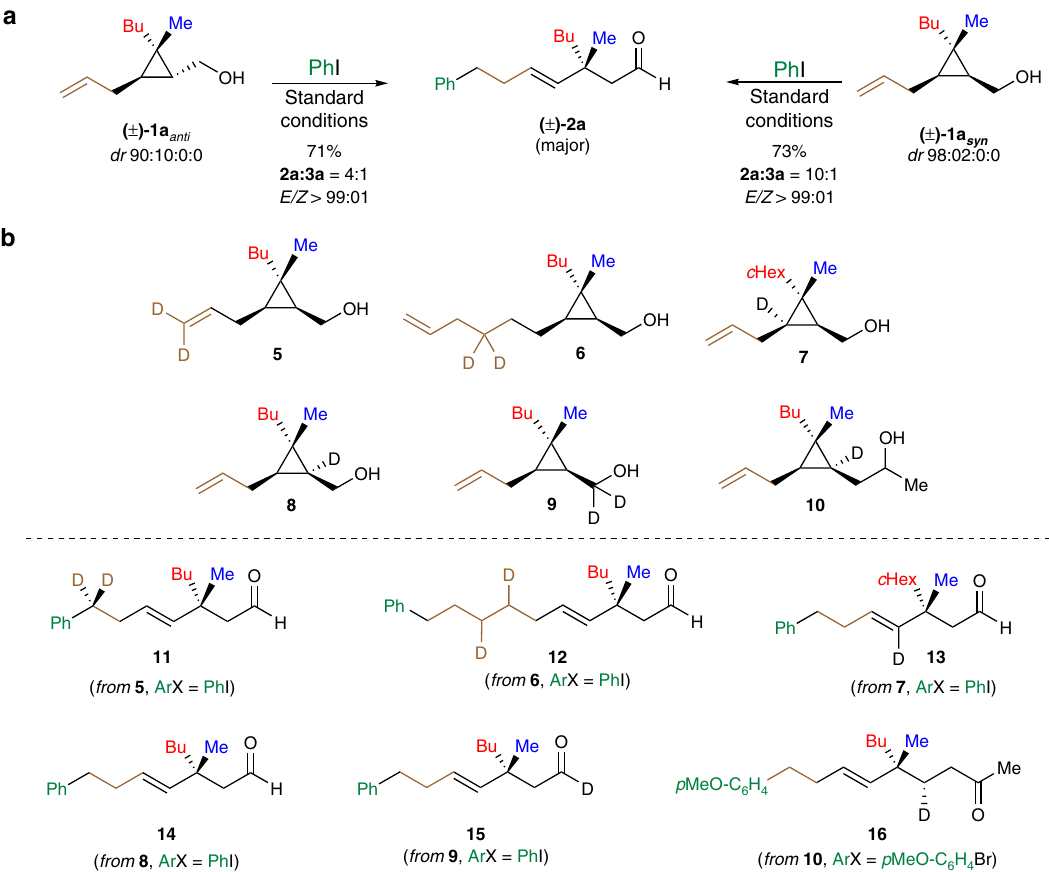
Figure 6 | Control and isotope labelling experiments. ( a ) Effect of the relative stereochemistry between the o -alkenyl chain and the alcohol residue on the reaction outcome using standard reaction conditions (see Fig. 3a). ( b ) Isotopic labelling experiments. Deuterium incorporation was confirmed by NMR and mass spectrometry analyses of products 5 – 16 after purification over column